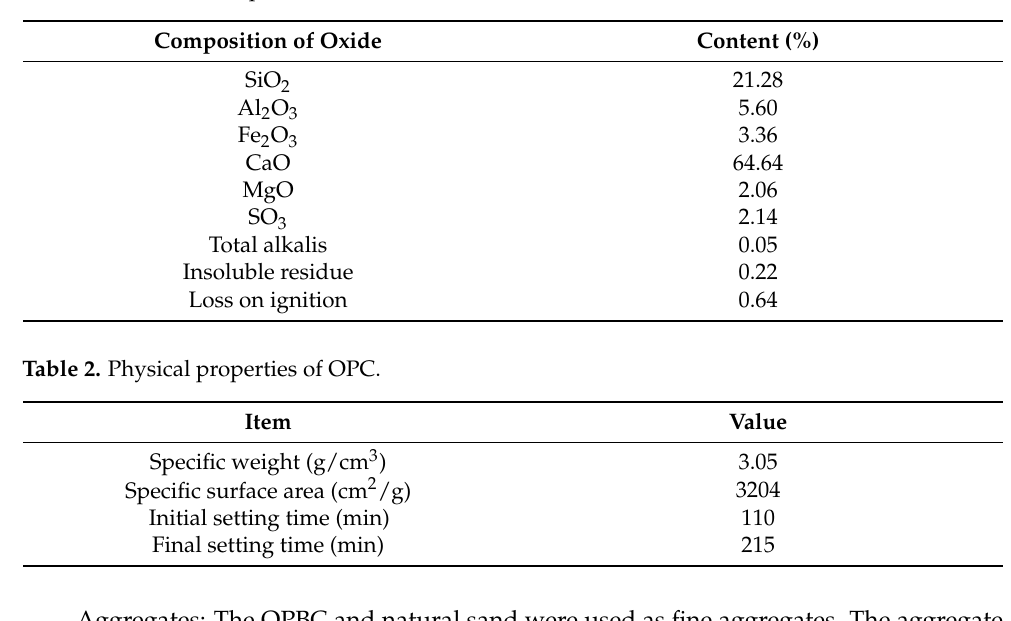
Table 1. Chemical compositions of OPC.